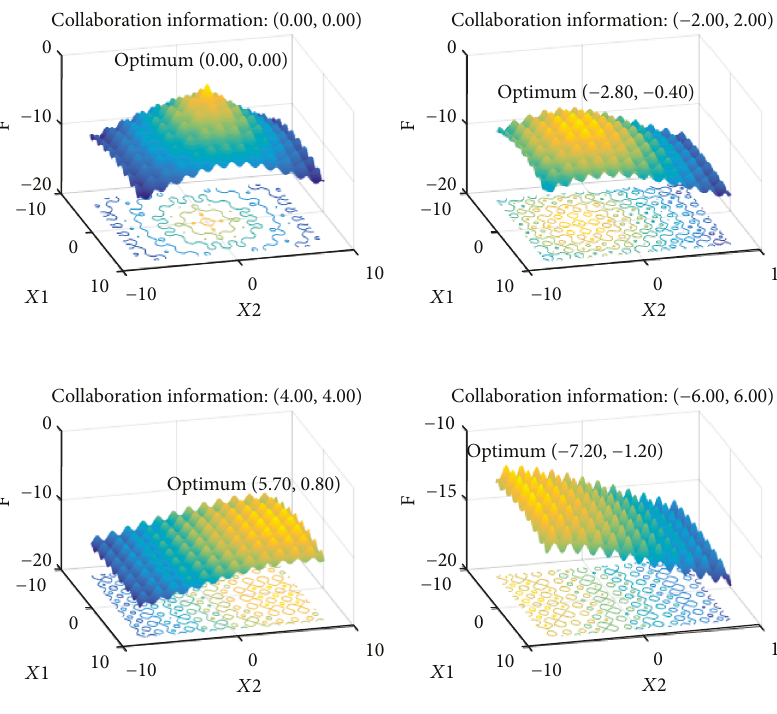
Figure 1: Demonstration of the dynamic nature of CC landscapes.